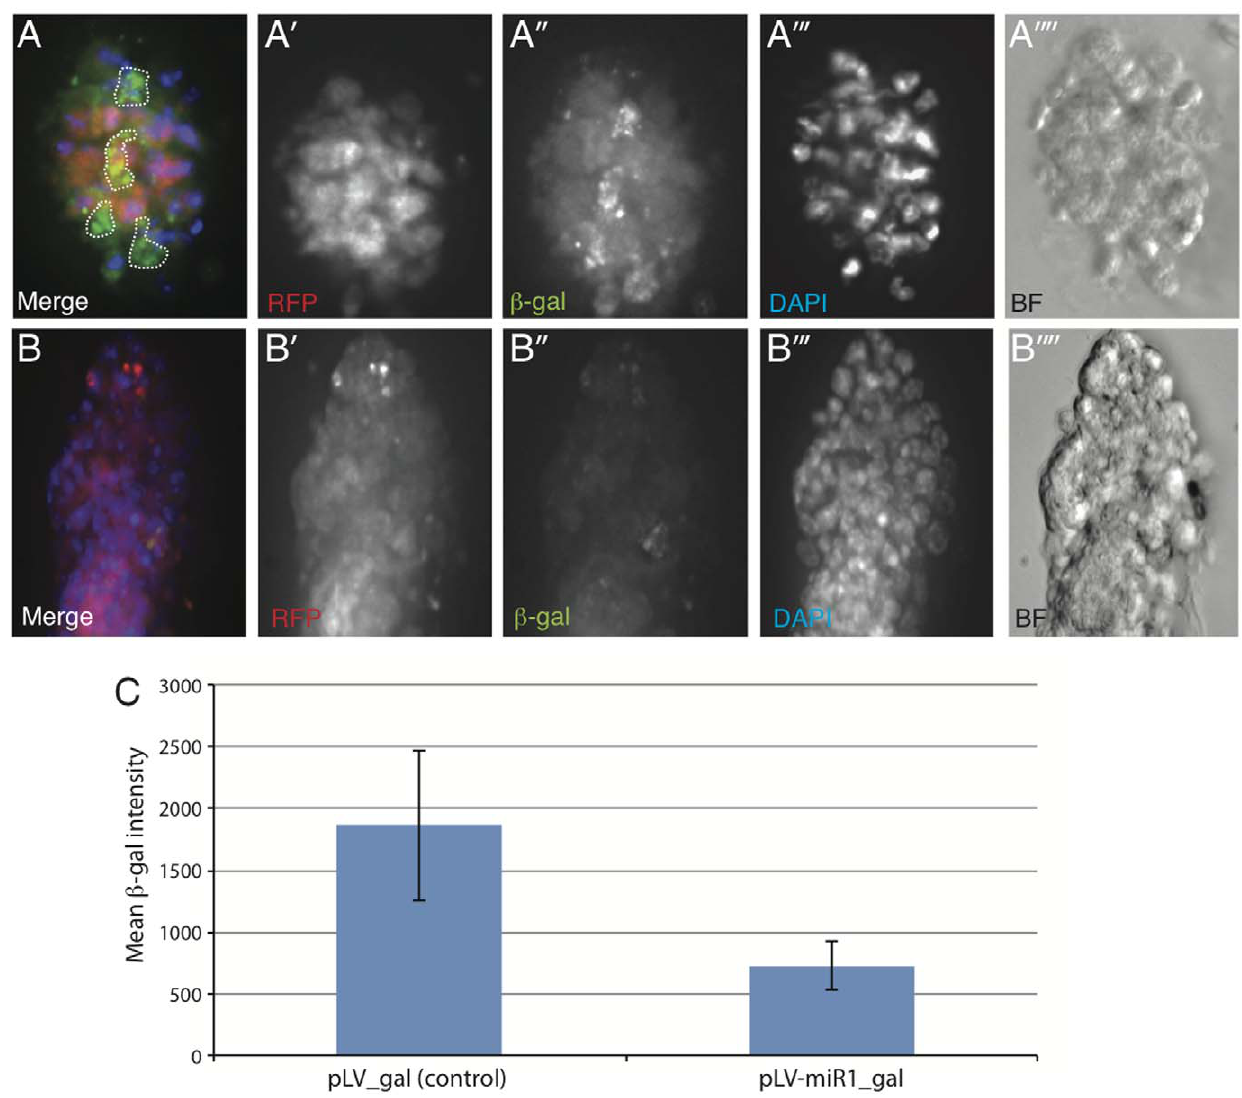
Figure 5. Lentiviral expression of miR-1 inhibits expression of the Wnt reporter, axin2/Conductin -LacZ in primary mouse mammary epithelial organoid cultures. (A-A 00 ) Representative image of organoid transduced with pLV-dsRed (Control) vector. (B-B 00 ) Representative image of organoid transduced with pLV-miR-1-dsRed lentiviral vector. The organoids transduced with control lentiviral vector (A 0 ) shows significantly higher expression of Axin2- b -gal compared to organoids expressing miR-1 (B 0 ). The dotted lines in panel A represent non-cellular auto-fluorescence, which was excluded from analysis of fluorescence intensity measured by NIS Elements Software. (C) Quantitative measurement of mean levels of b -gal (fluorescence intensity) in six individual organoids transduced with pLV-dsRed (Control) and seven individual organoids transduced with pLV-miR1- dsRed lentiviral vector. The average intensities were calculated for Region of interest (ROI) selected for each organoid using dsRed expression (that represents lentiviral infection) using the NIS Elements Software. Error bars denote standard deviation among